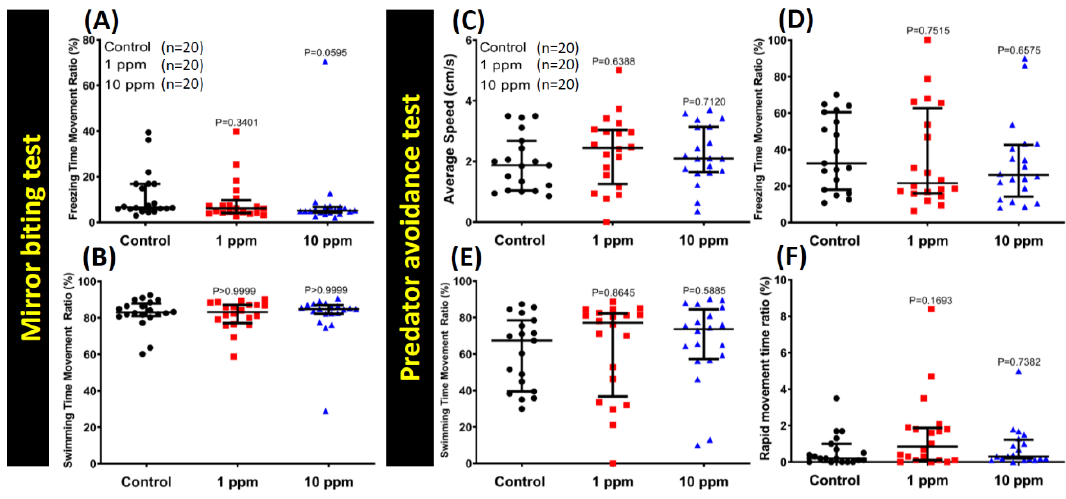
Figure A2. Mirror biting and predator avoidance tests behavior endpoint comparisons between control, 1 ppm, and 10 ppm Fe 3 O 4 MNPs-exposed zebrafish groups after two weeks of exposure. ( A ) Freezing time movement ratio and ( B ) swimming time movement ratio was analyzed in the mirror biting test. ( C ) Average speed, ( D ) freezing time movement ratio, (E) swimming time movement ratio, and ( F ) rapid movement time ratio were analyzed in the predator avoidance test. The data are expressed as the median with interquartile range and were analyzed by the Kruskal-Wallis test with Dunn’s multiple comparisons test as a follow-up test ( n = 20 for the all of the groups).